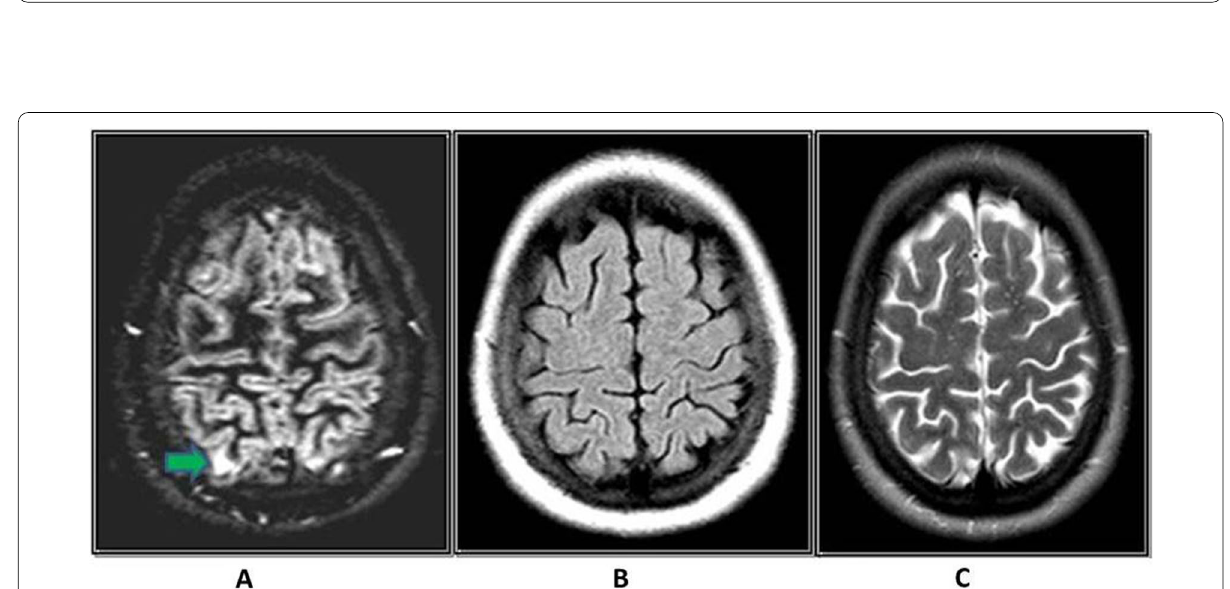
Fig. 4 Female patient 32-years-old with history of RRMS since 3 years presented by weakness, headache and visual disorder, EDSS DIR, Flair and T2 sequences, respectively) show MS plaques (1 thalami), 4 confluent lesion, 5 WM Lesion) = =